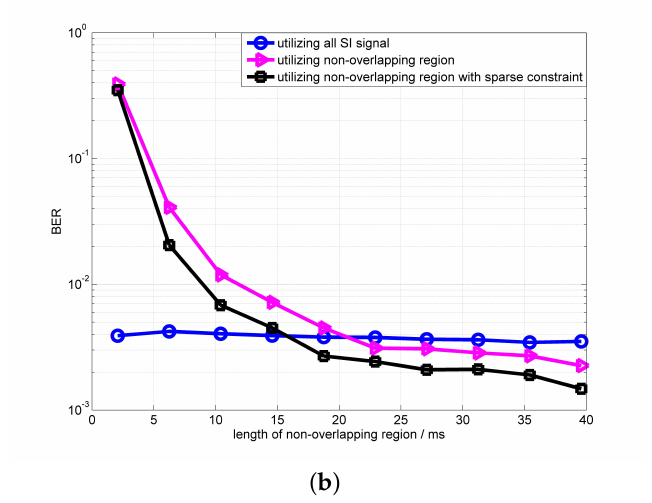
Figure 10. Performance of the OPRLS with sparse constraint ( a ) SIR = − 25 dB; ( b ) SIR = − 30 dB.